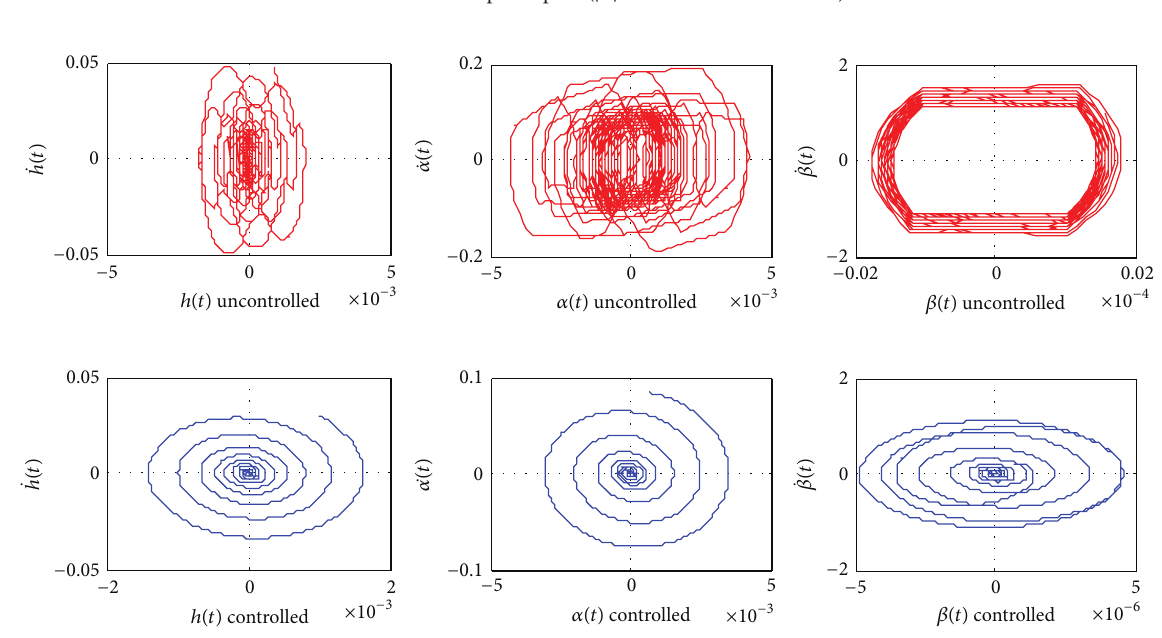
Figure 14: Case: phase plan ( |𝛿| = 0.6 ∘ and 𝑉 = 12.5